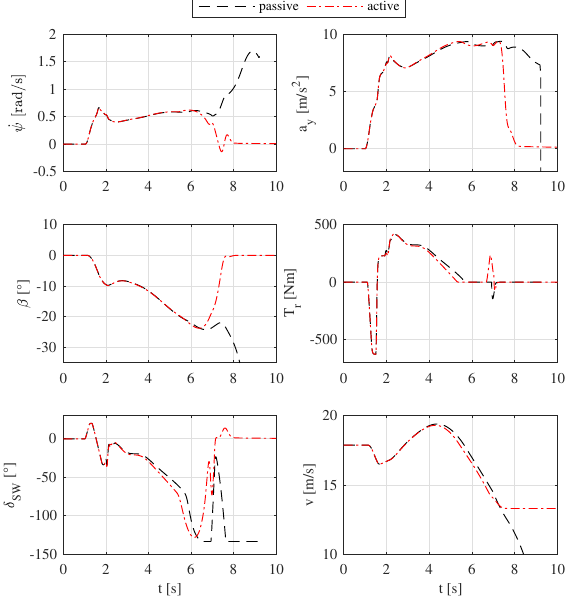
Figure 13. U-turn, low-skilled driver, dynamics